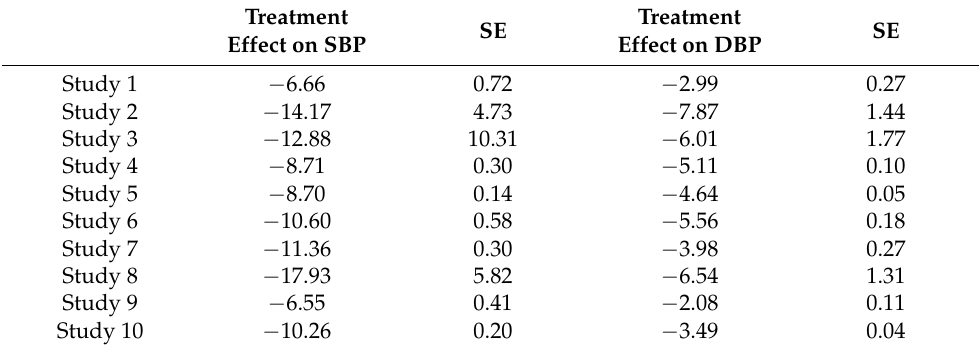
Table 1. The 10 studies from the blood pressure data. Each study provided the treatment’s effect on the systolic blood pressure (SBP) and the treatment’s effect on the diastolic blood pressure (DBP). Treatment Effect on SBP SE Treatment Effect on DBP SE